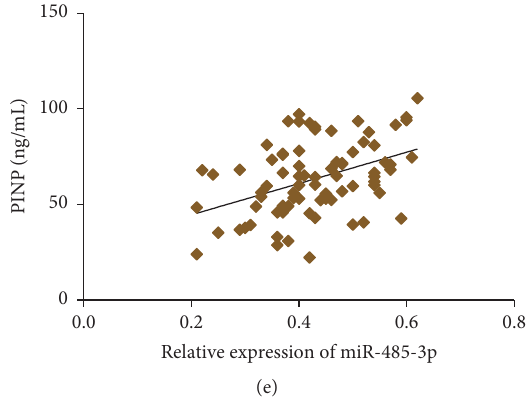
Figure 3: Pearson correlation analysis between miR-491-5p and miR-485-3p expressions, 25-(OH)VitD, PINP, and β -CTx.